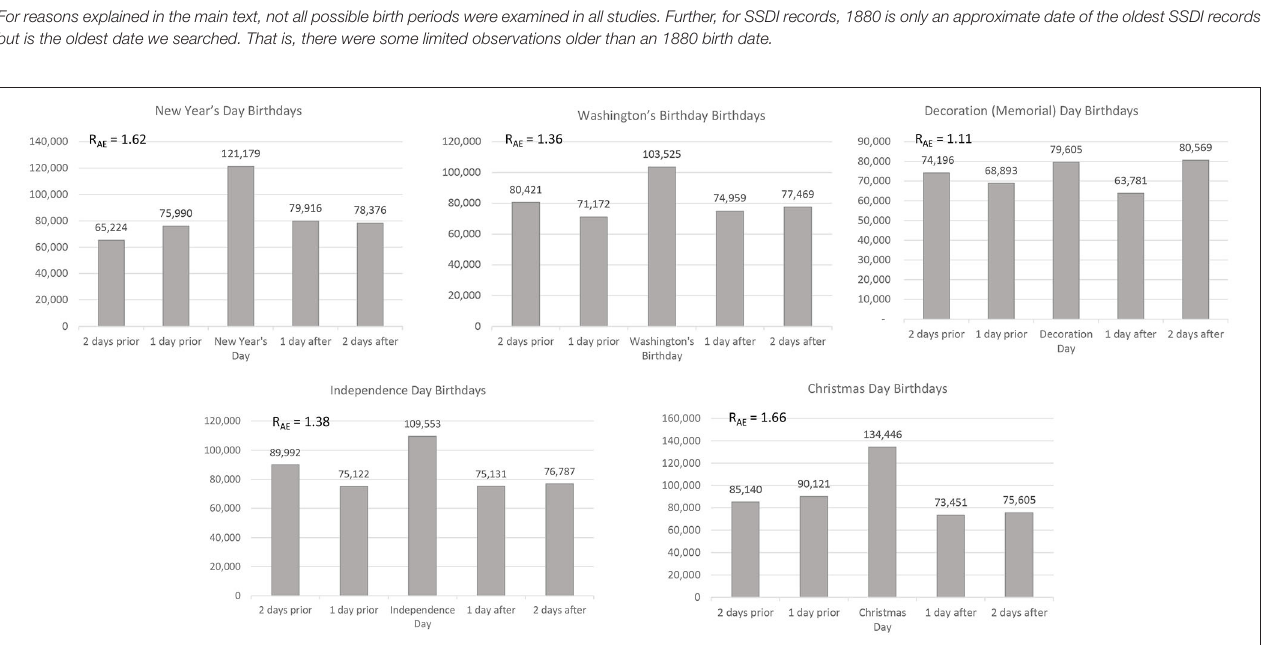
FIGURE 1 | Birthday selection: claiming a major holiday as a birthday for one’s child in the U.S. (1890–1910). Two days after Memorial Day was June 1st. It is predictable that parents overclaimed June 1st even more often than they overclaimed Memorial Day because – as we show in in Study 4 – the number 1 is one of the most highly liked of all calendar numbers. On the other hand, supplemental analyses also showed that January 1st was a much more commonly claimed birthday than the first day of any other month of the